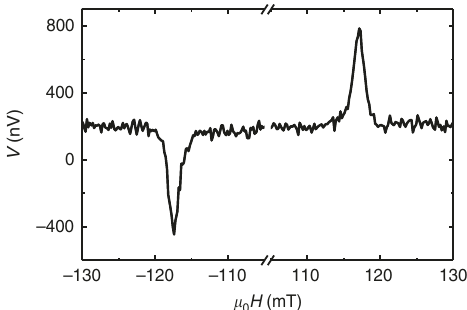
Fig. 4 Inverse Spin Hall Effect of BiYIG fi lms with in-plane magnetic anisotropy. Inverse Spin Hall Effect (ISHE) voltage vs magnetic fi eld measured on the Pt/Bi 1.5 Y 1.5 IG//sGGG sample in the FMR resonant condition at 6 GHz proving the interface transparency to spin current. The rf excitation fi eld is about 10 − 3 mT which corresponds to a linear regime of excitation. Bi 1.5 Y 1.5 IG//sGGG presents an in-plane easy magnetization axis due to a growth under